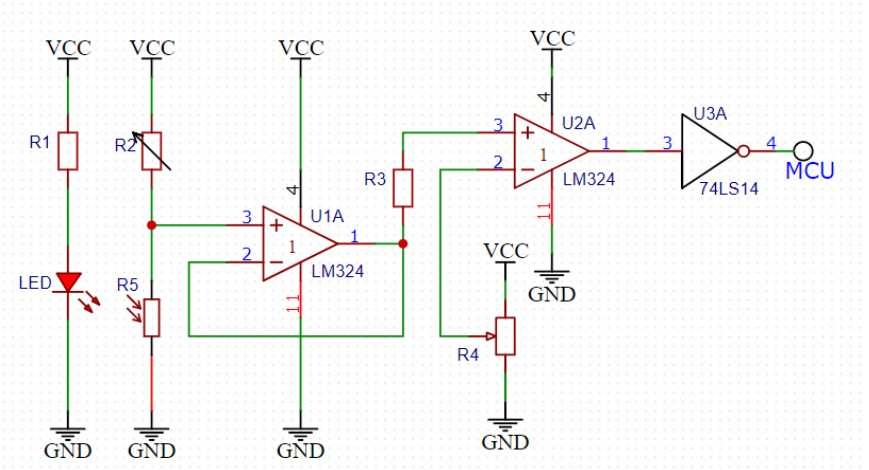
Figure 5. Sensor circuitry principal diagram.